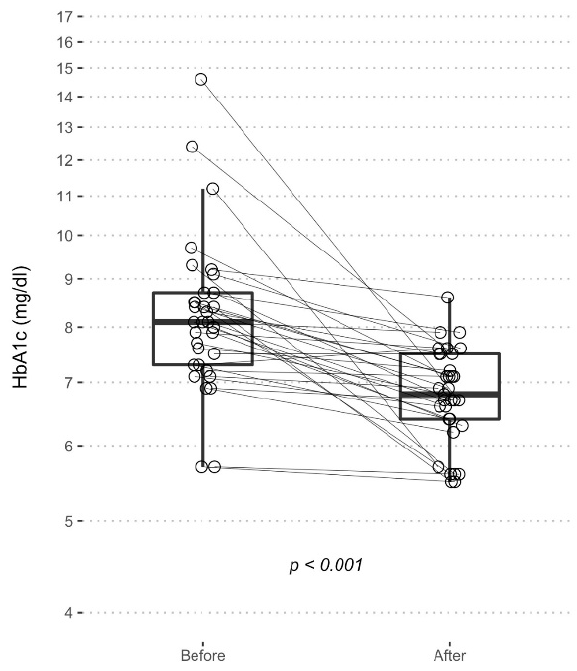
Figure 4. Boxplot represents HbA1c levels before and after EVLCD. Each point represents a single measurement, and the solid lines connects the two measurements of each patient.